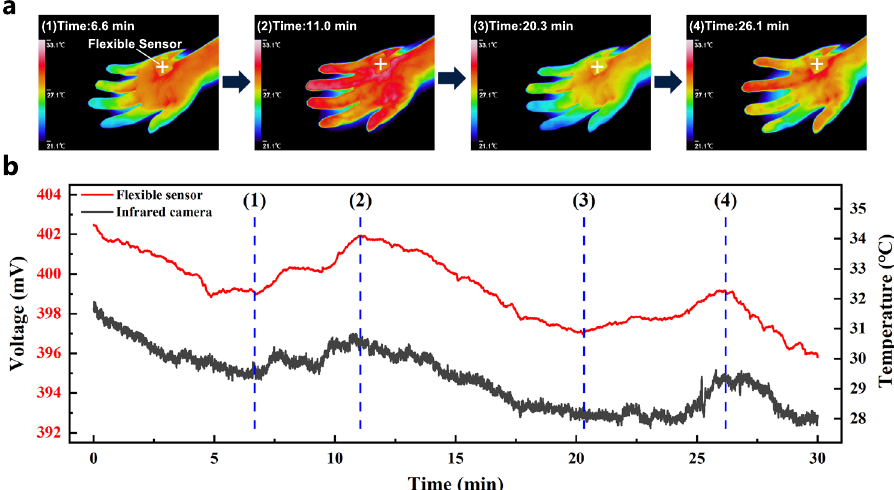
Fig. 4 Flexible sensors for monitoring the skin temperature change. a Infrared images for the skin temperature change process on the palm in an air-condition room at 17 °C. b Temperature response curves for the skin temperature change recorded by the fl exible sensor (red) and the infrared camera (black),